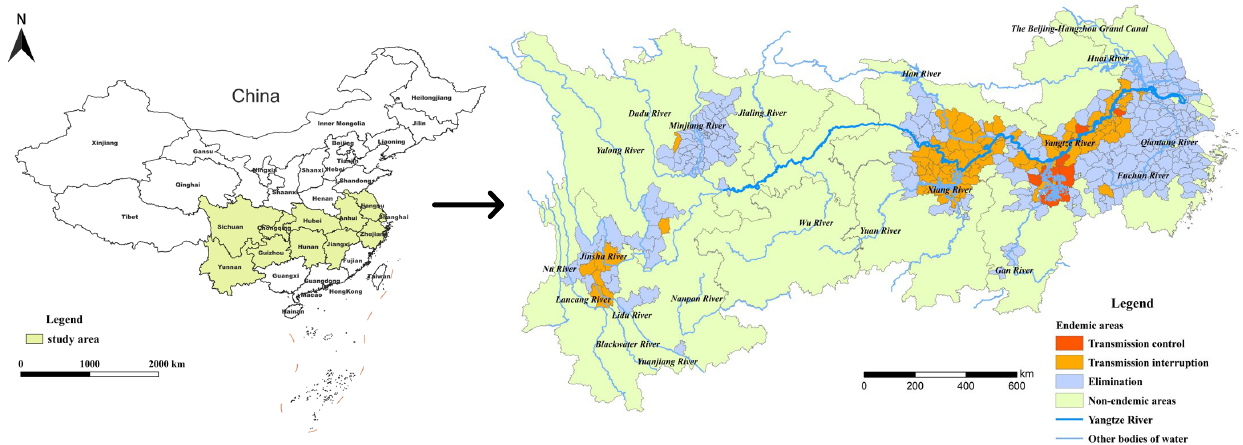
Figure 1. Location of the study area and stage of schistosomiasis control in endemic counties in 2021.